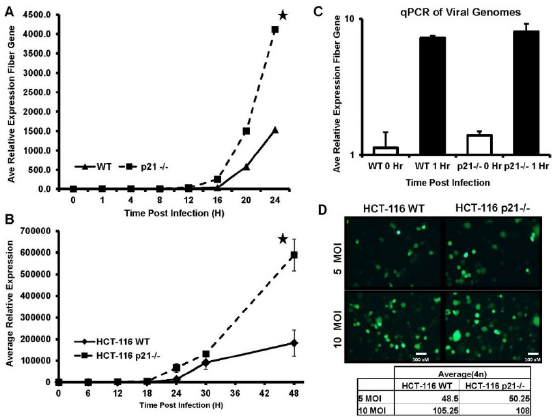
Figure 1. HCT-116 WT (wildtype) and p21 −/− cells were infected with 1 MOI (multiplicity of infection) of CN702 virus and infected cells were harvested for total DNA at indicated time points. Panel shows adenoviral DNA amplified by qPCR primers to f iber gene. Data normalized to β -Actin. Error bars S.E ( A ). HCT-116 WT and p21 −/− Cells were infected with 1 MOI of CN702 virus and infected cells were harvested for total DNA at indicated time points. Panel shows adenoviral DNA amplified by qPCR primers to f iber gene. Data normalized to β -Actin. Error bars represent ± S.E ( B ). Adenovirus entry by viral DNA qPCR. HCT-116 WT and p21 −/− cells were infected with 1 MOI of CN702 virus and infected cells were harvested for total DNA at indicated time points. Panel shows adenoviral DNA